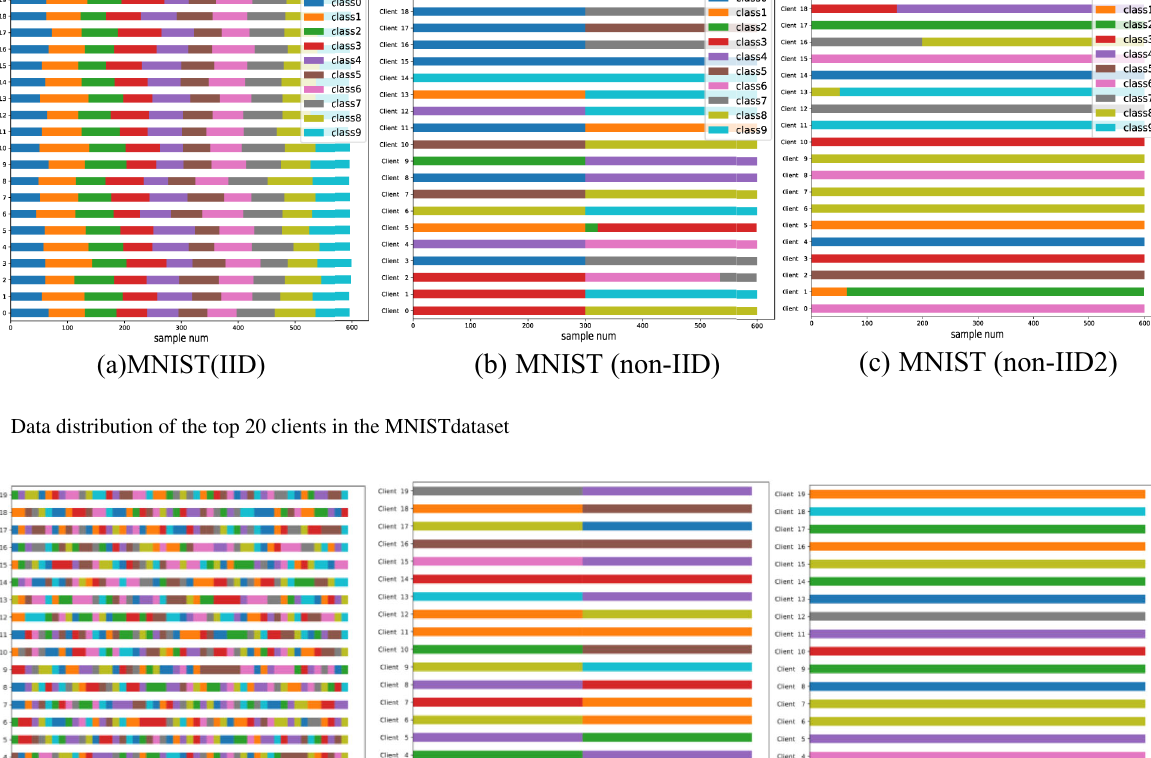
0 . 1 / (1 + t ); we set the parameter weight decay as 10 − 3 ; we set μ (cid:3) 10 − 3 for FedProx; K of 12 and 1 is selected for SCAFFOLD under moderate and massive device